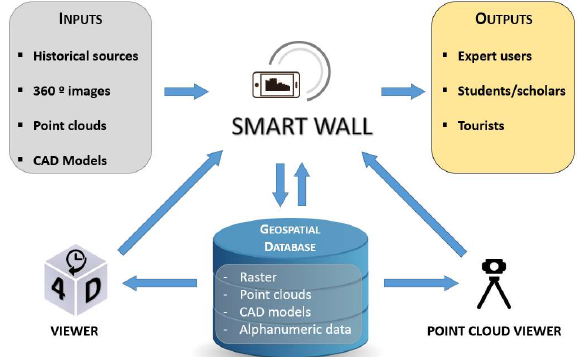
Figure 3. Flowchart of the SmarWall platform and main